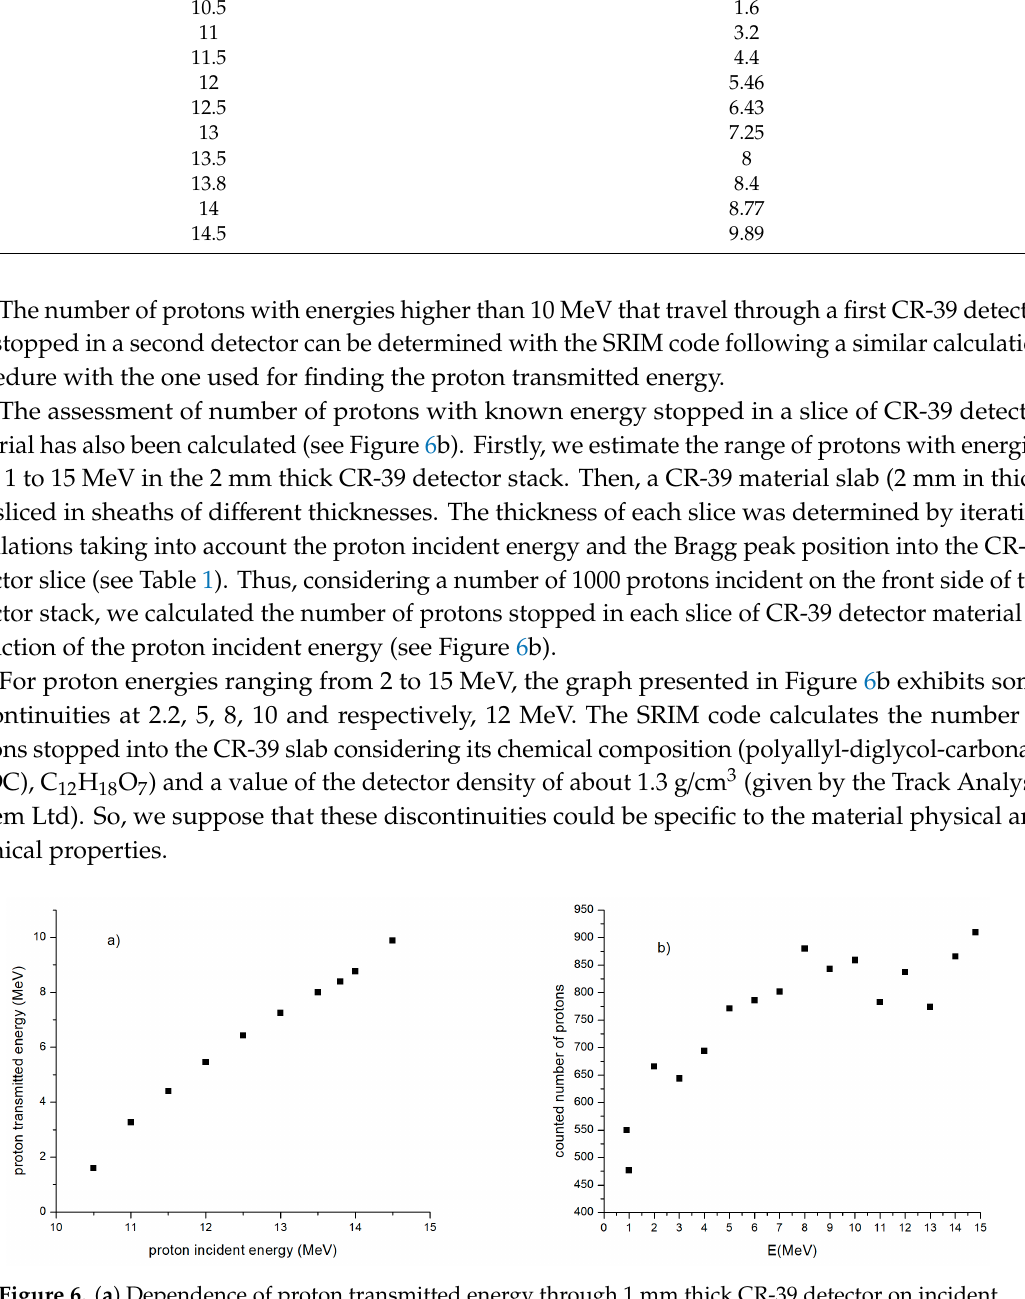
Table 2. Correspondence between the incident proton energy on the first and second CR-39 detector. Proton Incident Energy on Al + 2CR-39 Detectors Stack Calculated with SRIM 2013